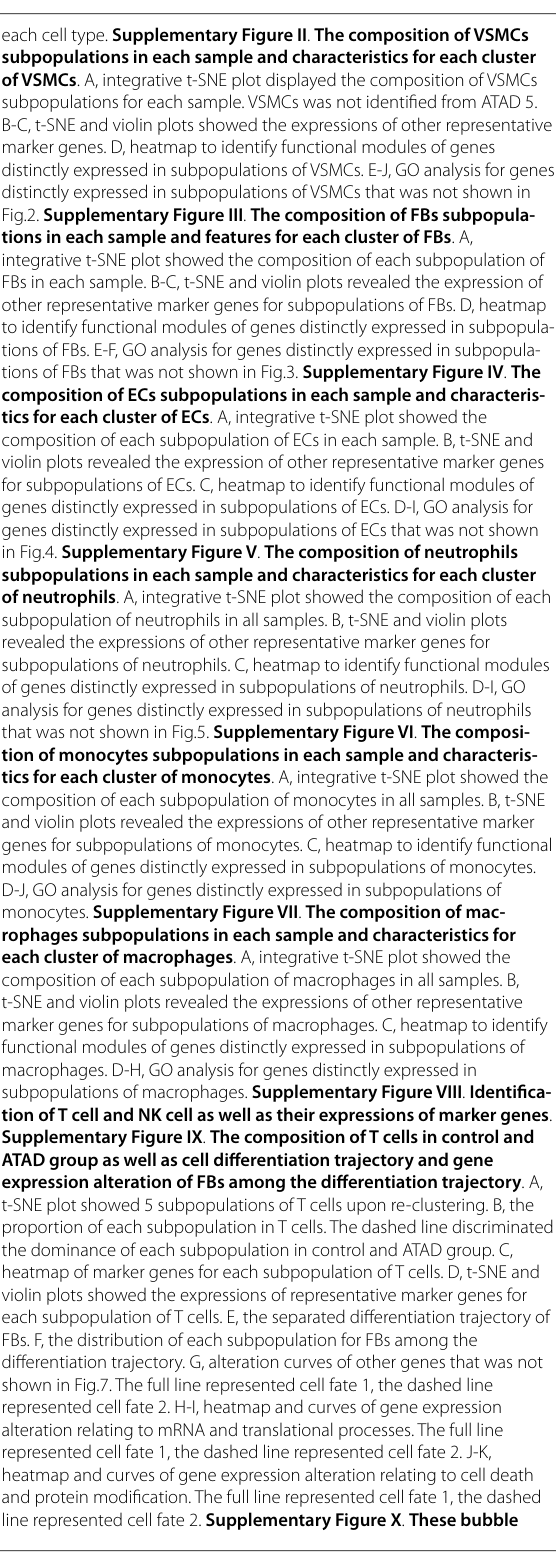
each cell type. Supplementary Figure II . The composition of VSMCs subpopulations in each sample and characteristics for each cluster of VSMCs . A, integrative t‑SNE plot displayed the composition of VSMCs subpopulations for each sample. VSMCs was not identified from ATAD 5. B‑C, t‑SNE and violin plots showed the expressions of other representative marker genes. D, heatmap to identify functional modules of genes distinctly expressed in subpopulations of VSMCs. E‑J, GO analysis for genes distinctly expressed in subpopulations of VSMCs that was not shown in Fig.2. Supplementary Figure III . The composition of FBs subpopula‑ tions in each sample and features for each cluster of FBs . A, integrative t‑SNE plot showed the composition of each subpopulation of FBs in each sample. B‑C, t‑SNE and violin plots revealed the expression of other representative marker genes for subpopulations of FBs. D, heatmap to identify functional modules of genes distinctly expressed in subpopula‑ tions of FBs. E‑F, GO analysis for genes distinctly expressed in subpopula‑ tions of FBs that was not shown in Fig.3. Supplementary Figure IV . The composition of ECs subpopulations in each sample and characteris‑ tics for each cluster of ECs . A, integrative t‑SNE plot showed the composition of each subpopulation of ECs in each sample. B, t‑SNE and violin plots revealed the expression of other representative marker genes for subpopulations of ECs. C, heatmap to identify functional modules of genes distinctly expressed in subpopulations of ECs. D‑I, GO analysis for genes distinctly expressed in subpopulations of ECs that was not shown in Fig.4. Supplementary Figure V . The composition of neutrophils subpopulations in each sample and characteristics for each cluster of neutrophils . A, integrative t‑SNE plot showed the composition of each subpopulation of neutrophils in all samples. B, t‑SNE and violin plots revealed the expressions of other representative marker genes for